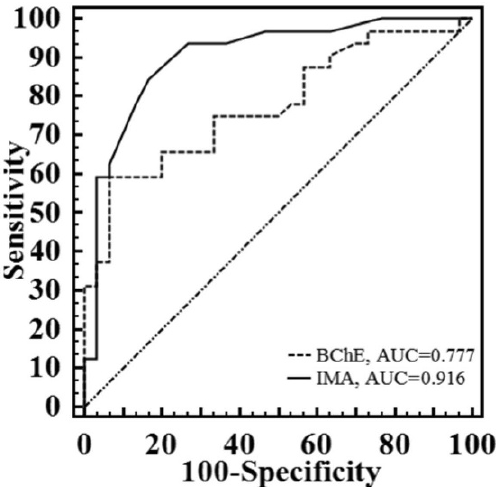
Figure 3 - The ROC plots show the significant difference between the AUCs for butyrylcholinesterase activity (0.777 ¡ 0.059) and ischemia-modified albumin (0.916 ¡ 0.038) ( z =2.154, p =0.031) in their ability to reflect obstructive sleep apnea. The optimal diagnostic cut-off for the modified albumin was 70.75 U/L (for a sensitivity and specificity of 84.4% and 83.3%, respectively). For butyrylcholinesterase activity, this point was 7890.08 U/L (for a sensitivity and specificity of 59.4% and